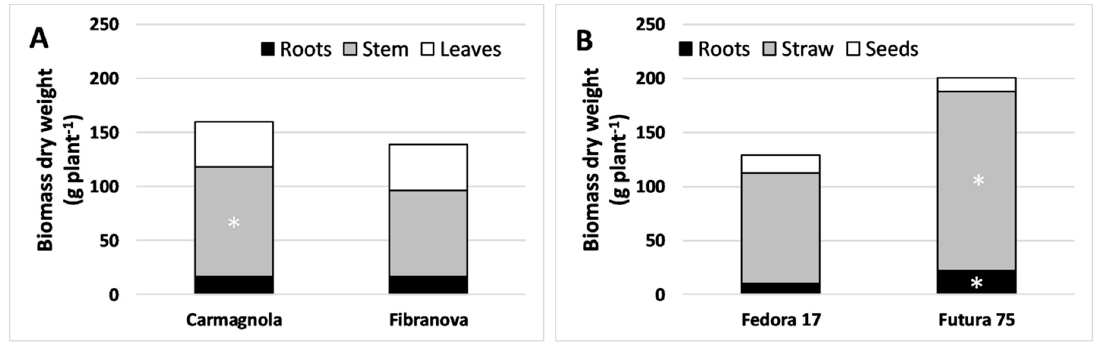
Figure 2. Biomass fractions dry weight of fiber ( A ) and seed ( B ) varieties at harvest time. Asterix indicates significant differences between the same fraction of the two varieties at p < 0.01 (Tukey’s HSD test).